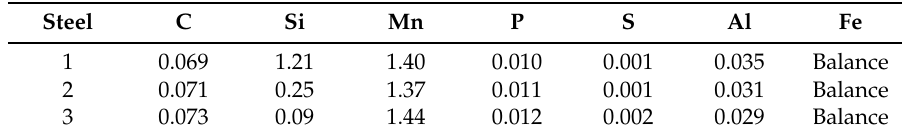
Table 1. The chemical compositions in tested steels (wt. %).